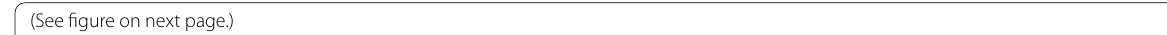
figure on next Fig. 5 Caspase-1/IL-1β inhibited membrane transport of GluA1 by inhibiting the interaction between Stargazin and GluA1. APP/PS1 mice were intraperitoneally injected with AC-YVAD-CMK or DMSO. WT C57/BL6 mice were served as control. a WB was performed to detect the expression of Stargazin in the hippocampal tissues of mice (One-way ANOVA). Hippocampal neurones were treated with Aβ 1-42 oligomer (10 μmol/L) for 24 h. Normal hippocampal neurones were served as control. b WB was performed to assess the expression of Stargazin in the hippocampal neuron cells (Student’s t test). c Co-IP assay was performed to verify the interaction between Stargazin and GluA1 in hippocampal neurones. Hippocampal neurones were transfected with pcDNA3.1-Stargazin mutant or pcDNA3.1-NC. Then, the modified hippocampal neurones were treated with Aβ 1-42 oligomer (10 μmol/L) combined with AC-YVAD-CMK (10 μmol/L) for 24 h. d WB was performed to detect the expression of GluA1 in the modified hippocampal neurones (Student’s t test). S: surface; I: intracellular. ** P < 0.01 vs. WT group; ## P < 0.01 vs. Ctrl group; $$ P < 0.01 vs. Aβ 1-42